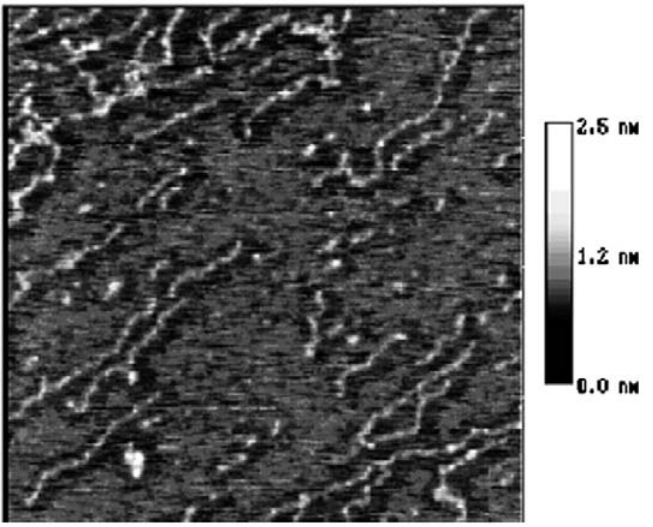
Figure 6. The AFM image of starch nanochains when heated in 100 °C water bath for 30 min, size 800 × 800